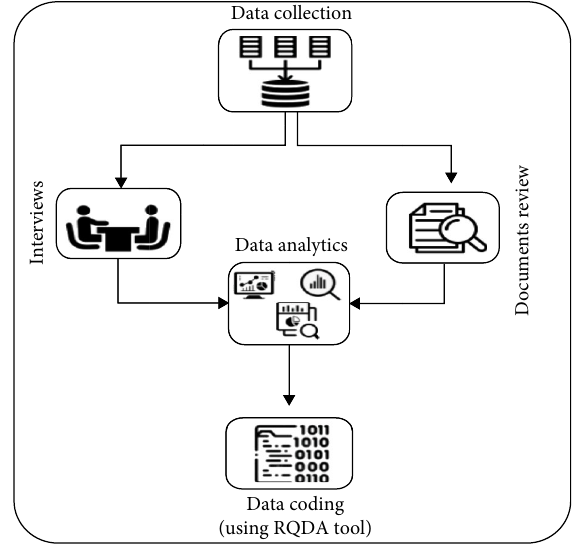
Figure 10: Components of research